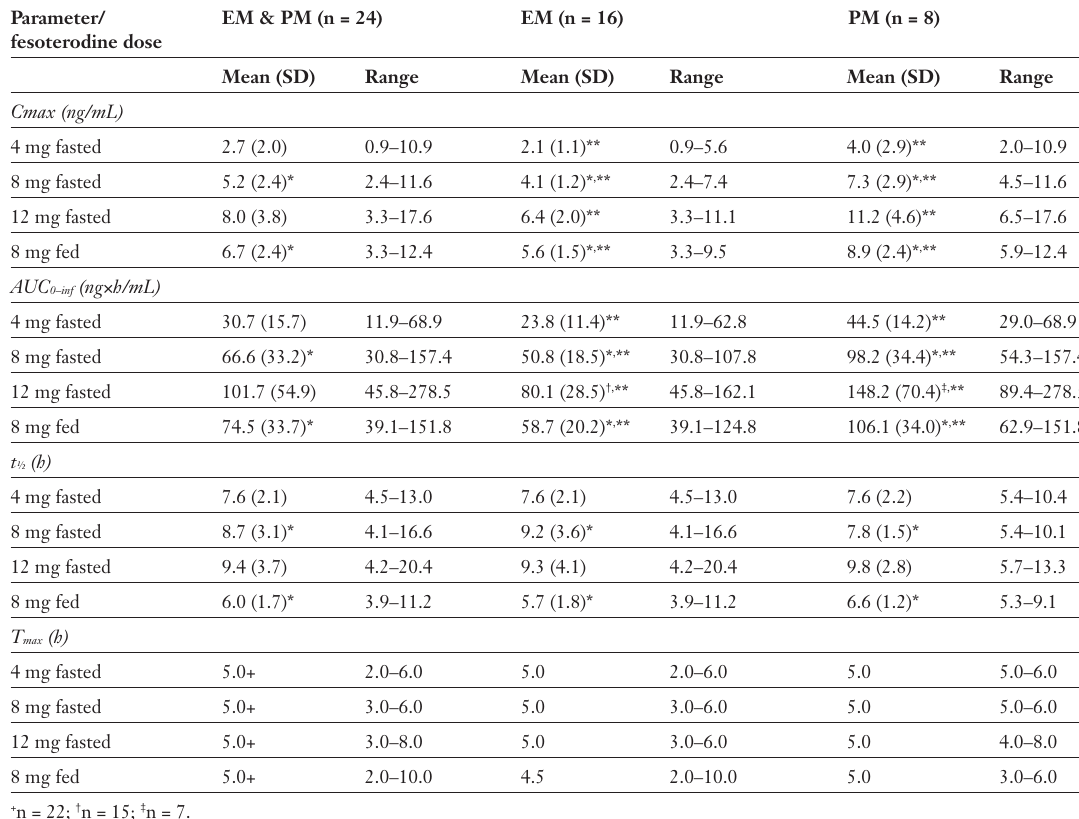
Table 1 Plasma pharmacoki- netic parameters of 5-HMT following administration of